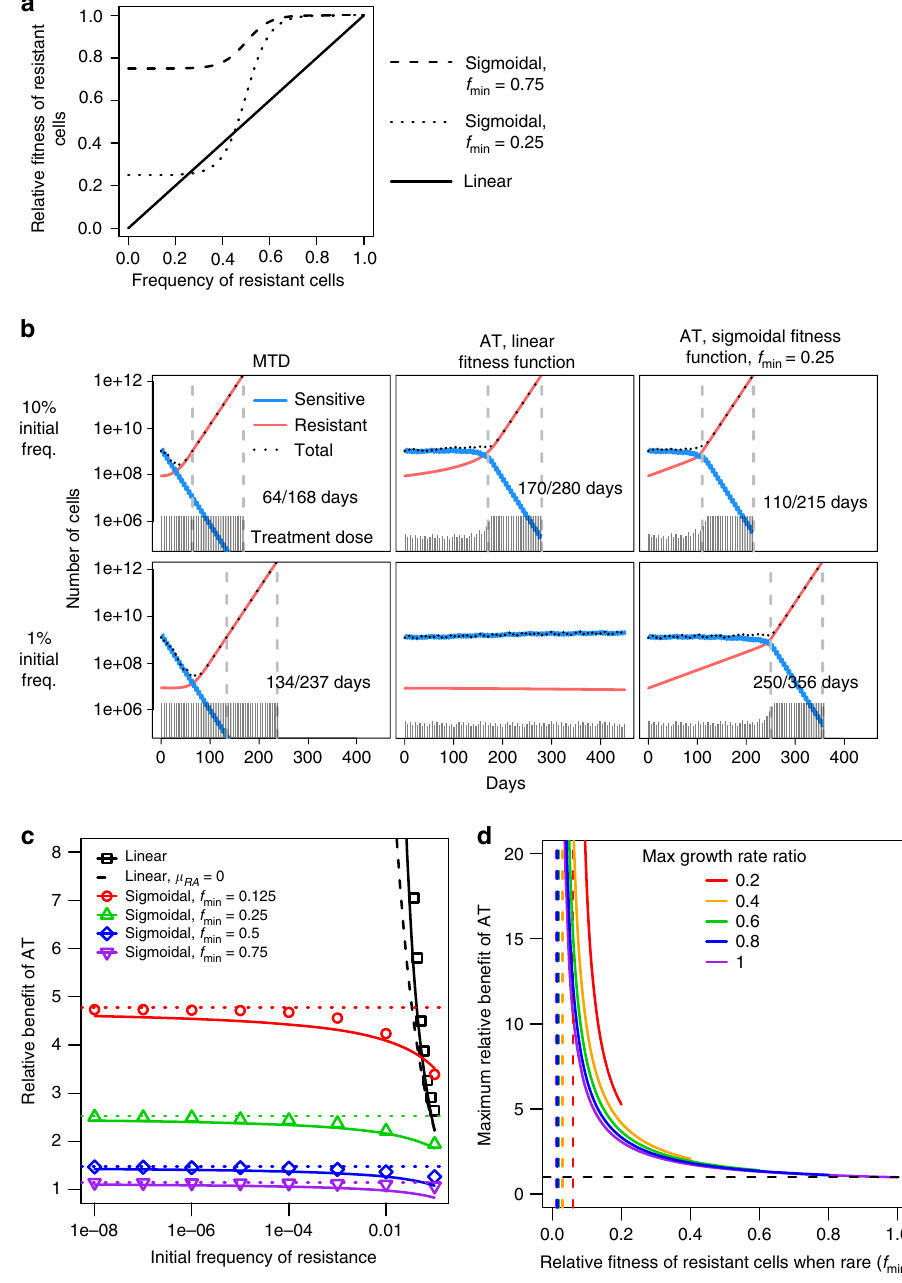
Fig. 1 Mathematical modelling of tumour evolutionary dynamics. a In mathematical modelling of cancer treatment outcomes, the function f describing the relationship between resistant cell relative fi tness and frequency may be assumed to be linear (solid curve) or sigmoidal. Two example relationships are shown for the relative fi tness of resistant cells when rare, f min = 0.25 (dotted curve) and f min = 0.75 (dashed curve). b Numerical results of a mathematical model for different therapy regimes, varied initial frequency of resistant cells, and varied function f . Population sizes are shown for sensitive cells (blue), resistant cells (red), and all cells (black). Days of progression-free survival ( fi rst vertical dashed line) and overall survival (second vertical dashed line) are shown. Grey vertical bars show the therapy dose. MTD = maximum tolerated dose; AT = adaptive therapy. c Mathematical model predictions for the progression-free survival bene fi t of adaptive therapy (relative to maximum tolerated dose therapy) vs. initial frequency of resistant cells. Symbols represent numerical results; lines are approximate analytical solutions; dotted lines are the upper bounds of the approximate analytical solutions. Outcomes are shown for fi ve models assuming different functions f . The fi rst model (black solid curve and square points) assumes a linear function, and assumes that the therapy slightly increases the mortality rate of resistant cells, μ R . An analytical approximation is also shown for the case μ R = 0 (dashed black line). Other models assume that f is sigmoidal. d Maximum relative survival bene fi t of adaptive therapy vs. f min , assuming a sigmoidal function f . Curves are shown for different values of λ R / λ W , which is the maximum growth rate of resistant cells, relative to the growth rate of sensitive cells. The vertical asymptotes are at μ RA / λ R and the horizontal asymptote is at 1. Parameter values are taken from a previous study 7 to facilitate comparison. Unless speci fi ed otherwise, λ W = = log(2)/10, IC50 = 1, IC50 = 100, ρ = 1, θ = 5 days, N = 10 9 , k = 20, and c = λ R W R MTD 0